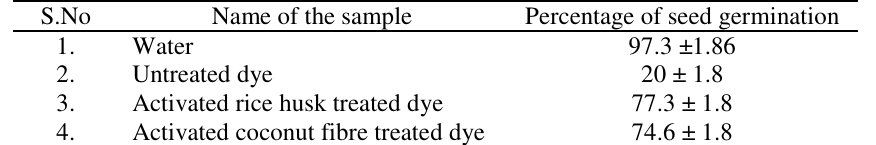
Table 4. The effect of contact time on percentage of seed germination of Vigna mungo